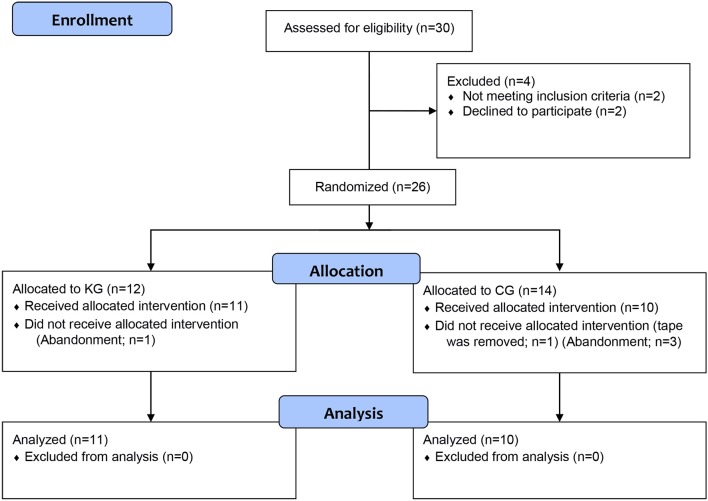
Study flowchart.